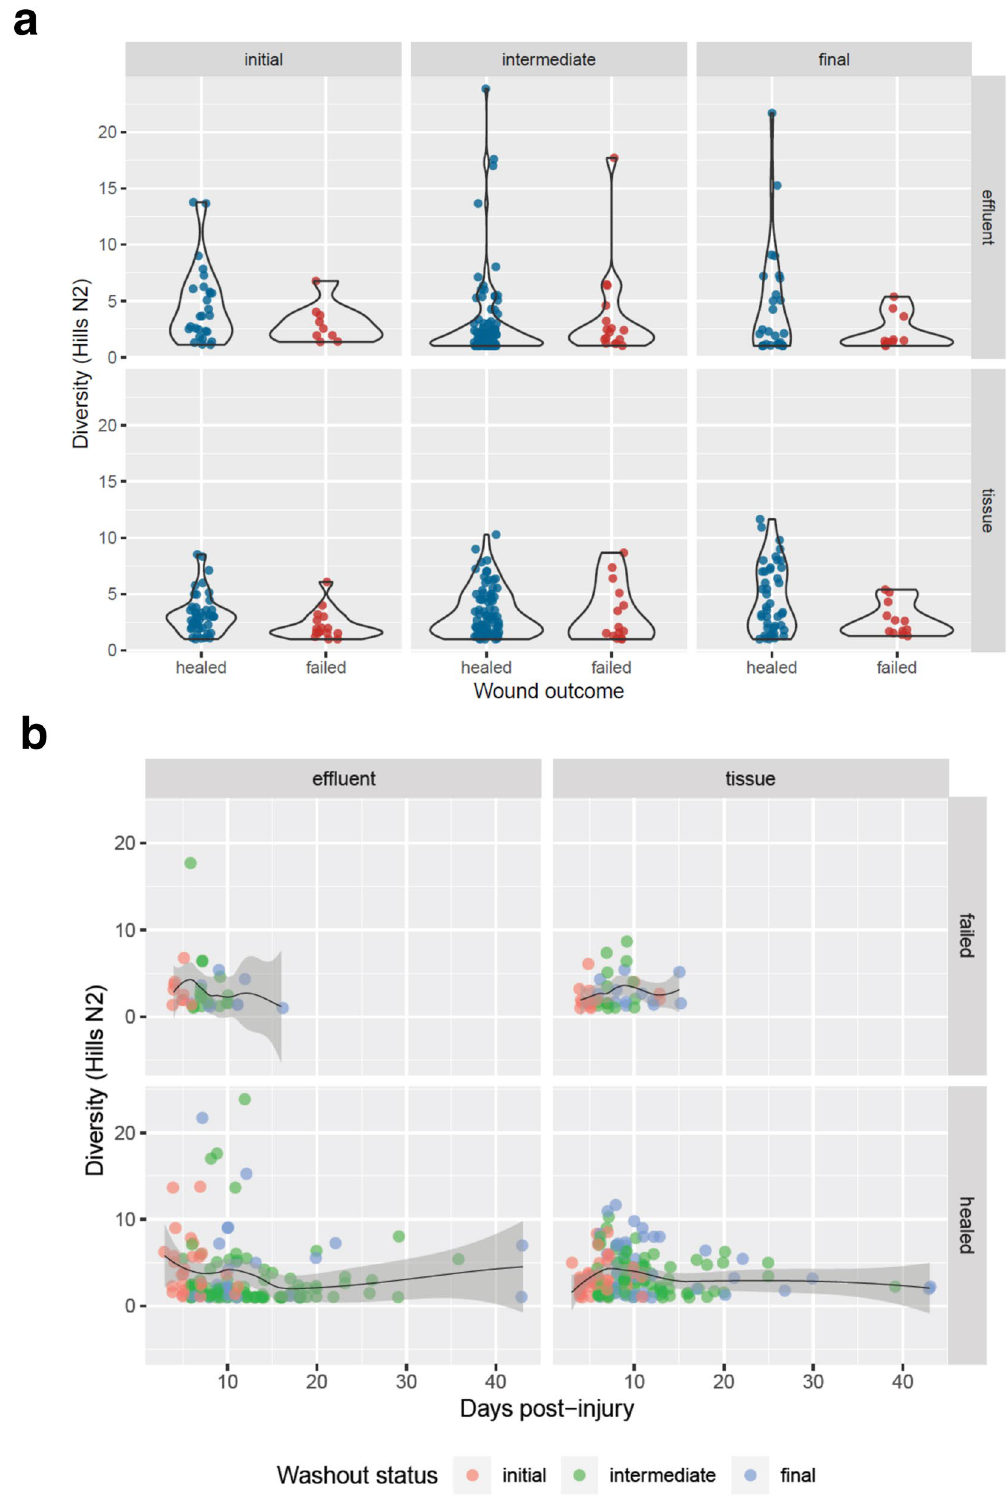
Figure 2. Alpha diversity of bioburden according to wound status. Metagenomic sequence data from wound specimens was used to calculate bioburden diversity through assessment of richness. ( a ) Microbial taxonomic diversity as represented by Hill’s N 2 (reciprocal Simpson index) at the genus level, per sample, in distinct samplings from wounds. Diversity trends are shown in comparison to wound outcome. ( b ) Effective number of genera (Hill’s N 2 ) shown according to increasing number of days post injury. Specimen timepoint category is indicated via color of the corresponding point. Shaded area surrounding loess trendlines indicates 95% confidence interval about the average N 2